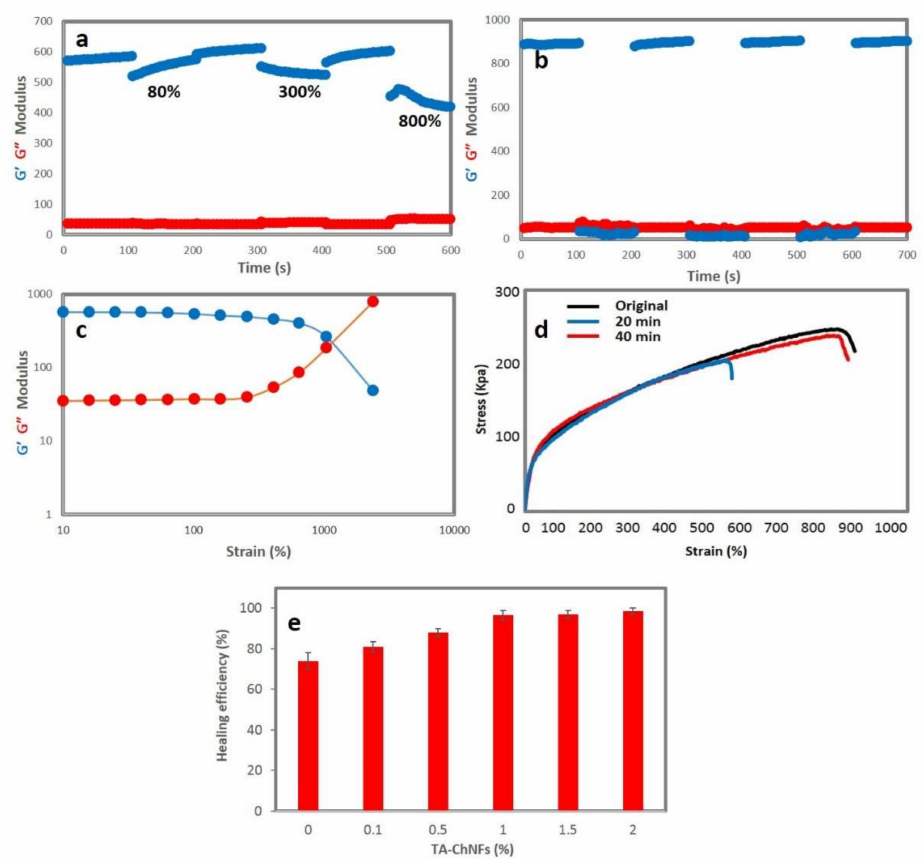
Figure 4. ( a ) Breakup and reformation ability of the hydrogel containing 1 wt.% TA-ChNFs at di ff erent strains = 1, 80, 300, and 800% and a fixed time interval; ( b ) breakup and reformation ability of the hydrogel containing 1 wt.% TA-ChNFs at 1 and 1000% strains and a fixed time interval; ( c ) shear-thinning behavior of the hydrogel containing 1 wt.% TA-ChNFs; ( d ) typical stress–strain curves of the pristine and healed hydrogels containing 1 wt.% TA-ChNFs; and ( e ) healing e ffi ciency of the hydrogels at di ff erent